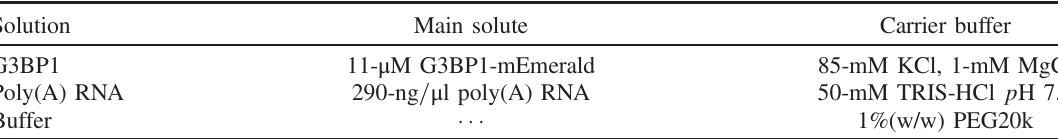
TABLE III. Solution content of syringes used in microfluidic experiments for the G3BP1-poly(A) RNA system.